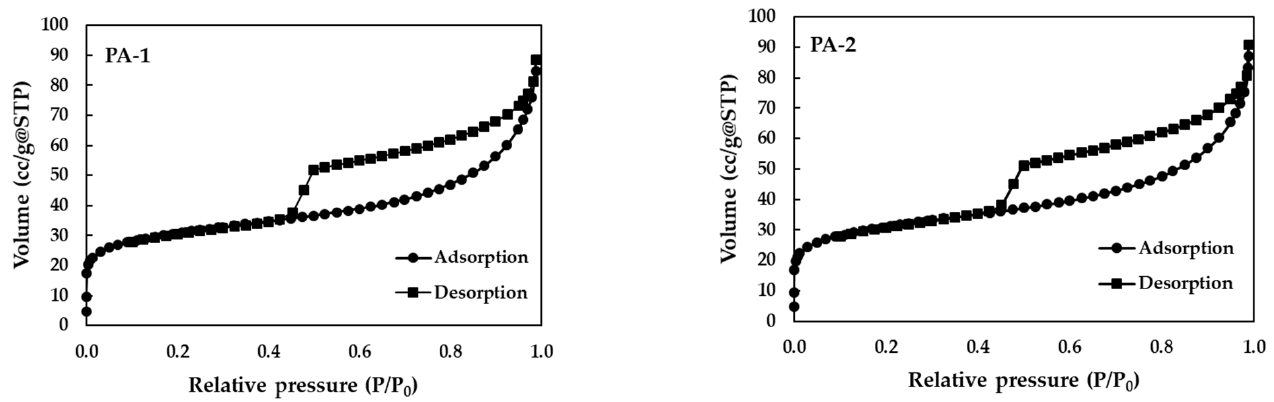
Figure 2. Nitrogen adsorption isotherm (BET) at 77 K of PA-1 and PA-2. (The samples were pre- heating at 200 °C for 16 h under vacuum conditions before measurement).